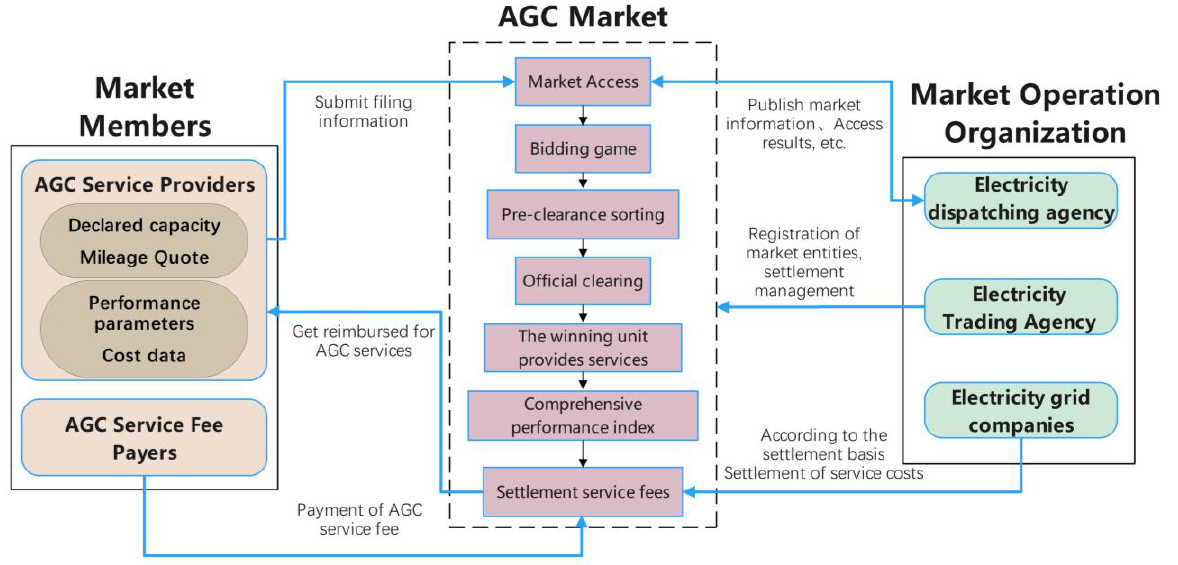
Figure 1. The framework structure of frequency regulation ancillary services market and its opera- tion process.